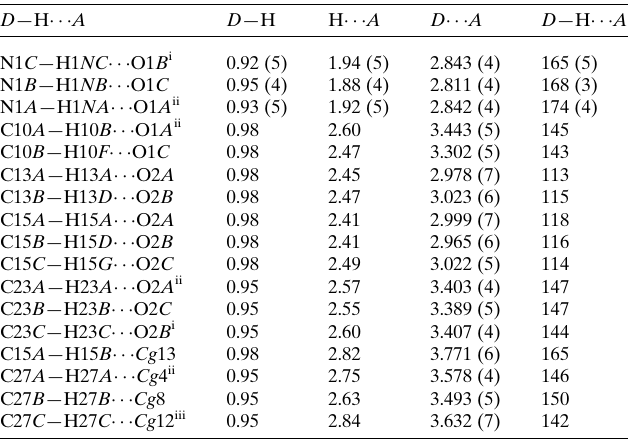
Table 1 Hydrogen-bond geometry (A˚ , (cid:4) ). Cg 4, Cg 8, Cg 12 and Cg 13 are the centroids of the C18 C –C23 C , C18 A –C23 A , C18 B –C23 B , and C18 B –C29 B rings, respectively. D —H (cid:2)(cid:2)(cid:2) A